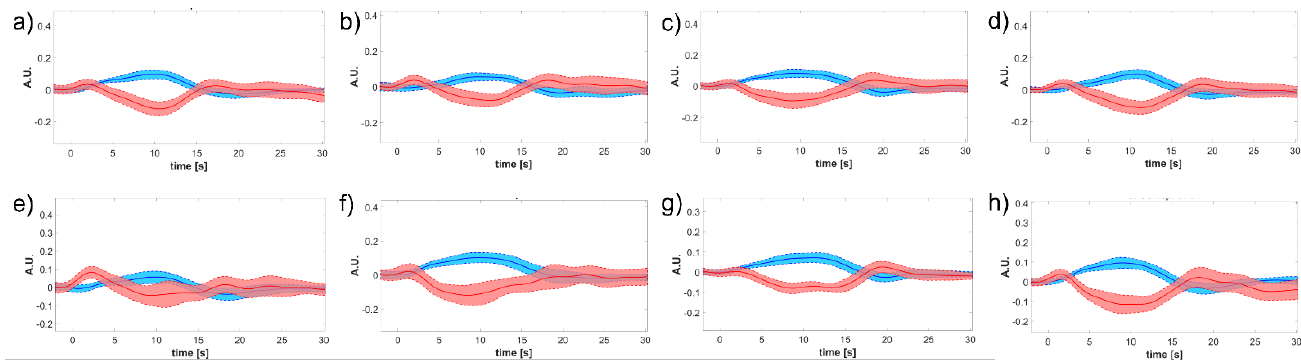
Figure 8. Subject-specific block-averaged responses across pipelines of ∆ [ HbO 2 ] and ∆ [ HbR ] related to left-hand motor grasp and a measurement channel placed over the left motor region (i.e., ipsilateral hemisphere). ( a ) SC-MARA-spline, ( b ) MC-MARA-spline, ( c ) SC-MARA-tPCA, ( d ) MC-MARA-tPCA, ( e ) HybridMARA-spline SG, ( f ) HybridMARA-tPCA SG, ( g ) TDDR, and ( h ) Wavelet method.